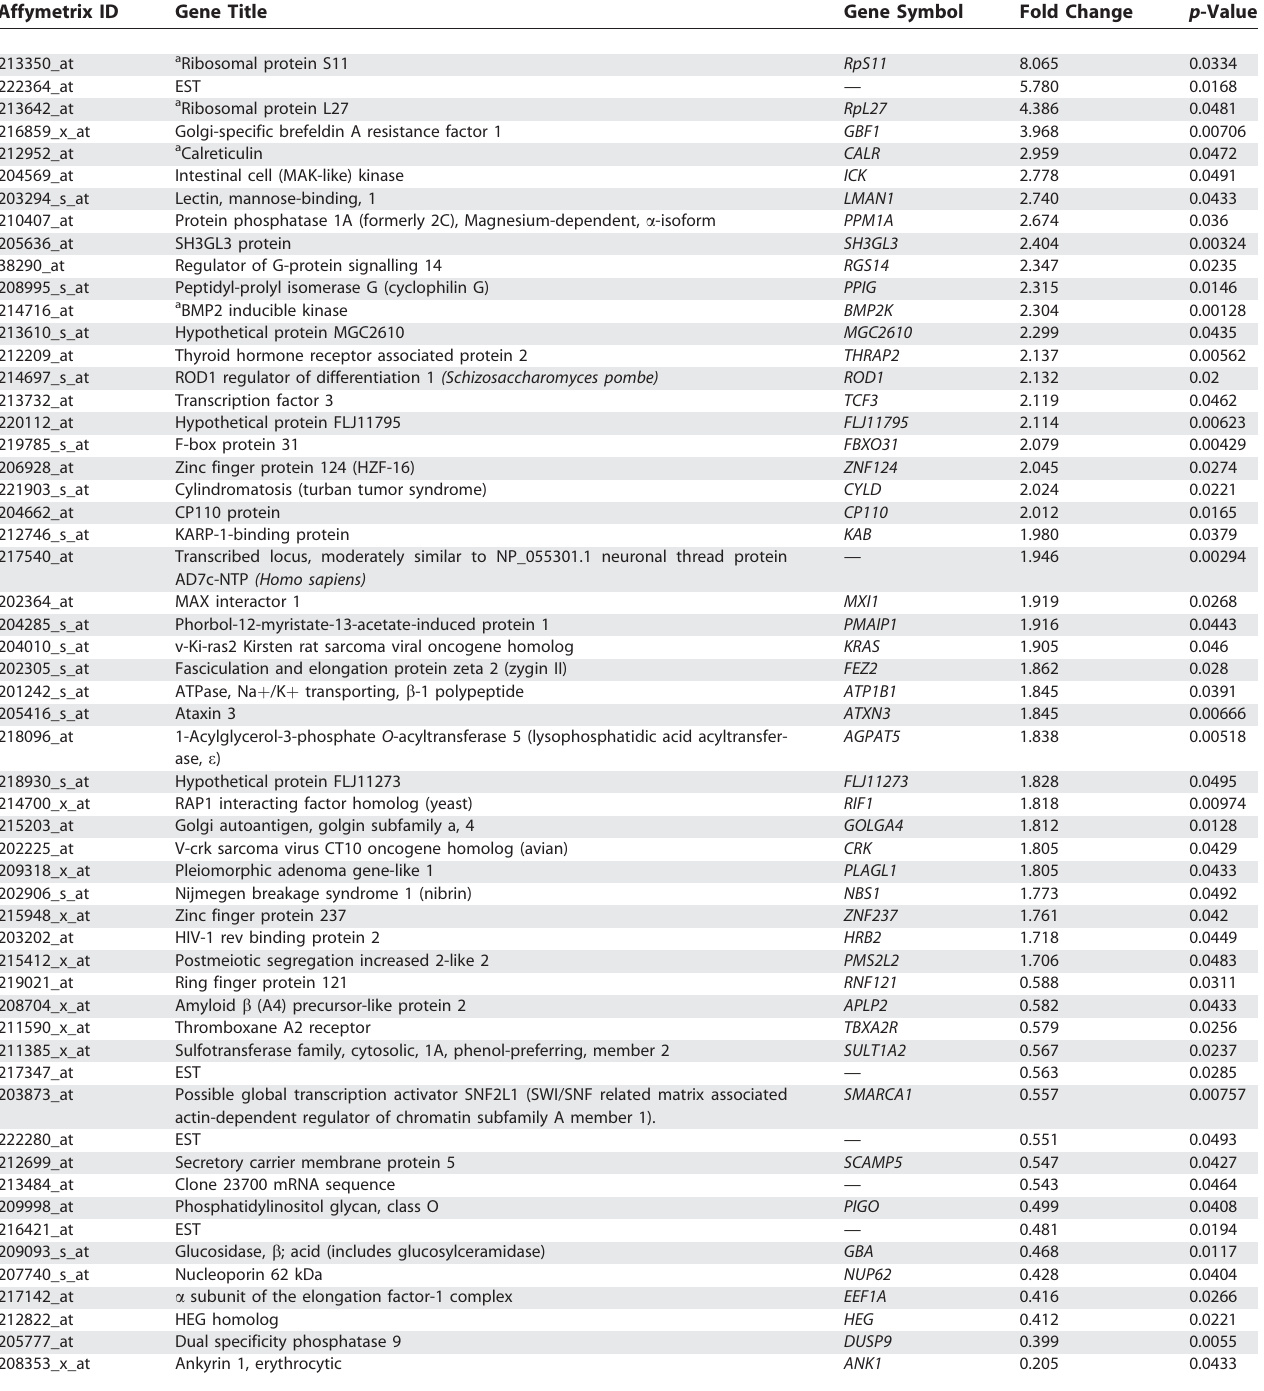
Table 3. Genes That Changed by More Than 1.7-Fold in 2 l M ADMA Treated HCAEC Compared to